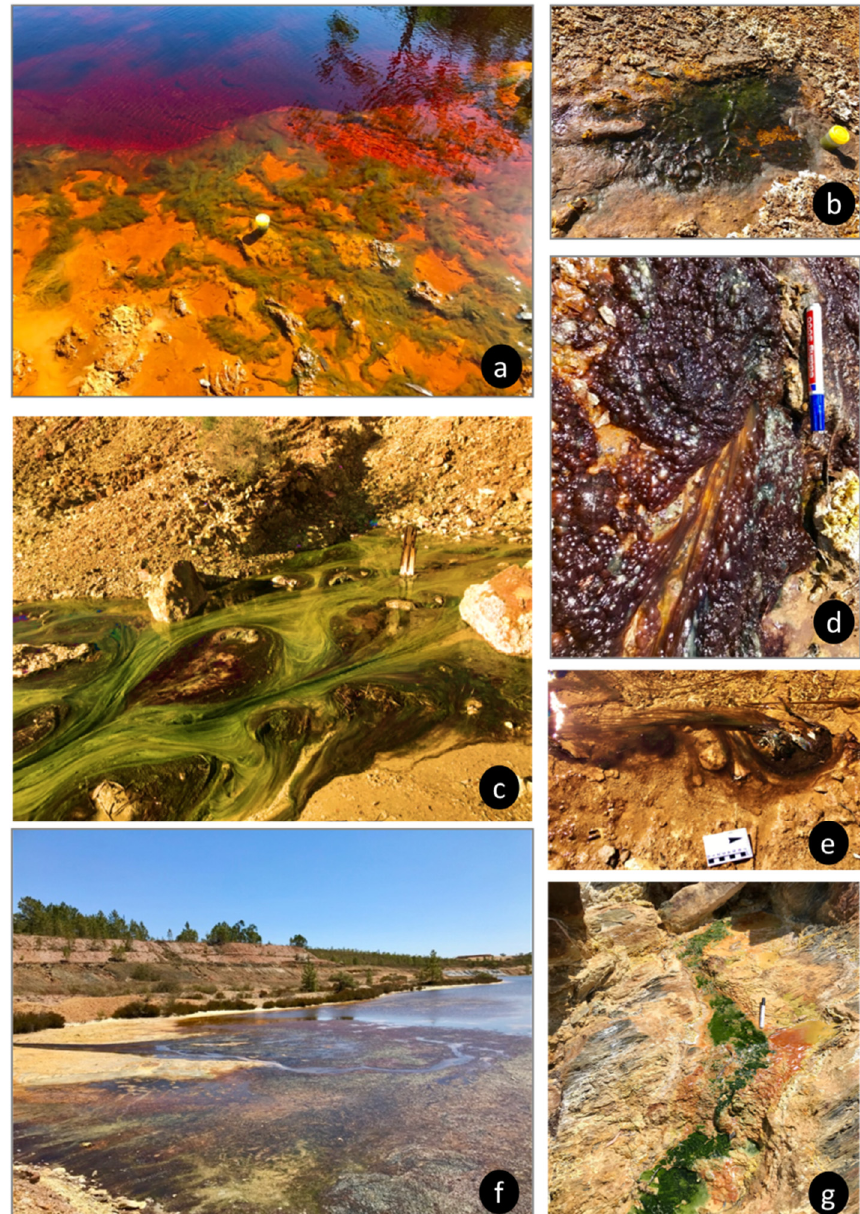
Figure 4. ( a ) Macroscopic observations of intense red-orange colour, reddish-yellow iron-precipitates and the presence of typical green algae observed in waters channels; ( b ) detail of small green algae in the sediment; ( c ) presence of layer brown-purplish intercalated with green algae filaments; ( d ) purplish brown colour of senescent algae with oxygen bubbles; ( e ) algae filaments with brown shades in low water course (P5); ( f ) bloom of algae patches, coexisting with efflorescent salts, and covering the surface bed at P3; ( g ) green algae located on rocky substrate in a small